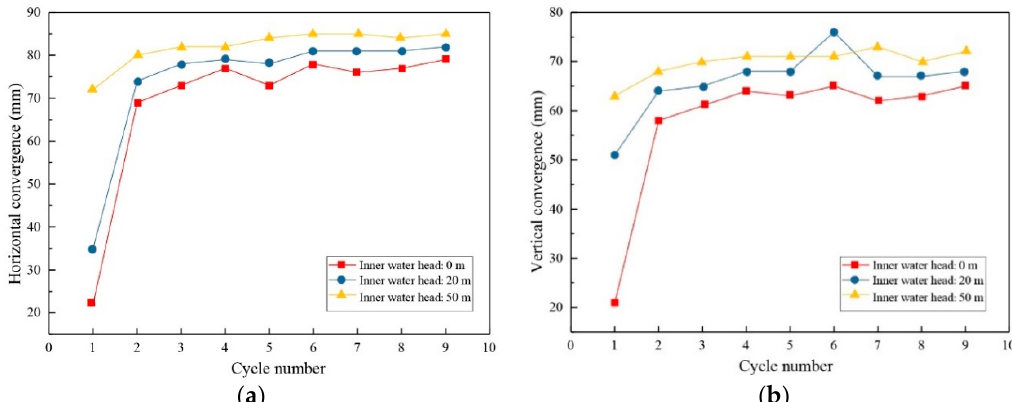
Figure 13. Evolution of convergence deformation at representative loading stages with the number of loading cycles: ( a ) horizontal; and ( b ) vertical.